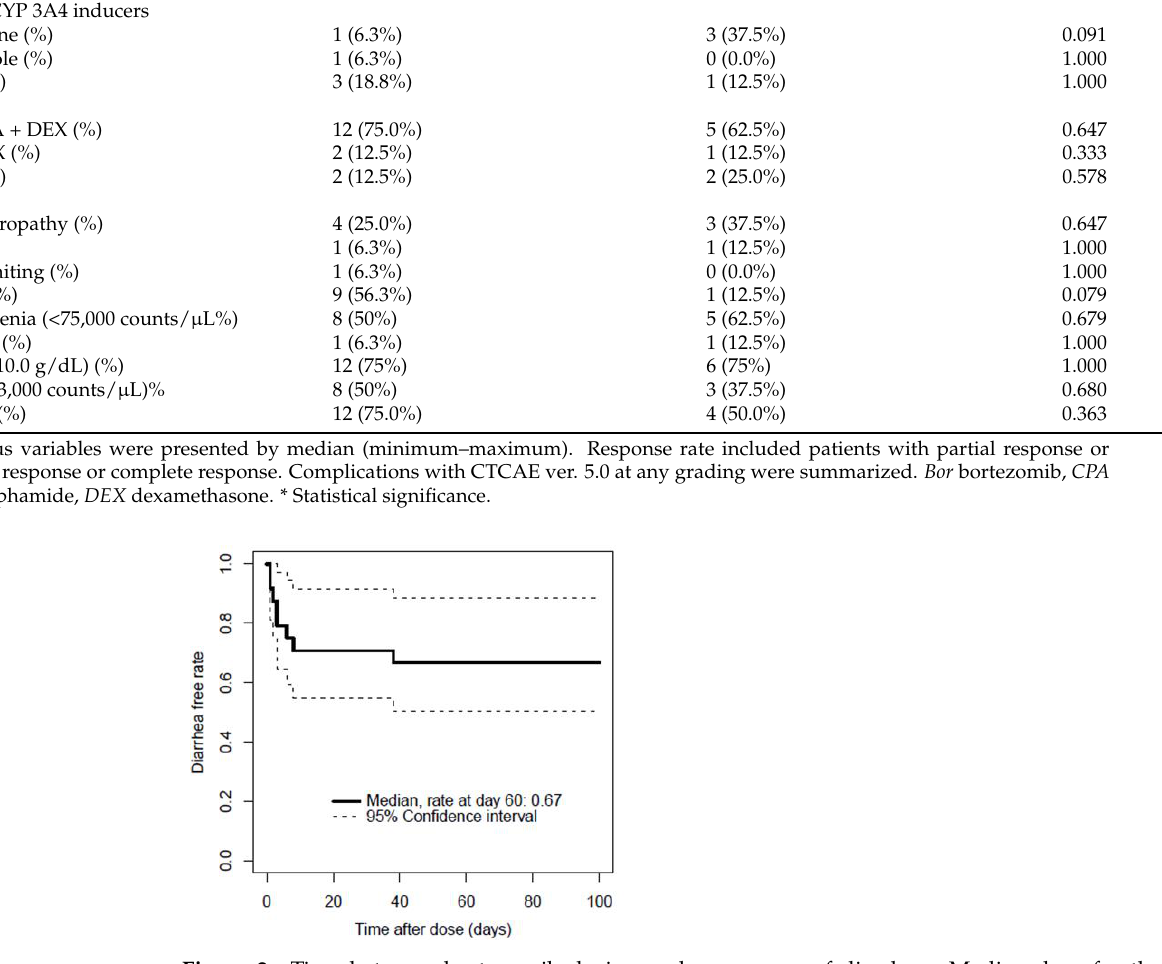
Figure 2. Time between bortezomib dosing and emergence of diarrhea. Median days for the emergence was three; diarrhea free rate at day 60 was 0.67.